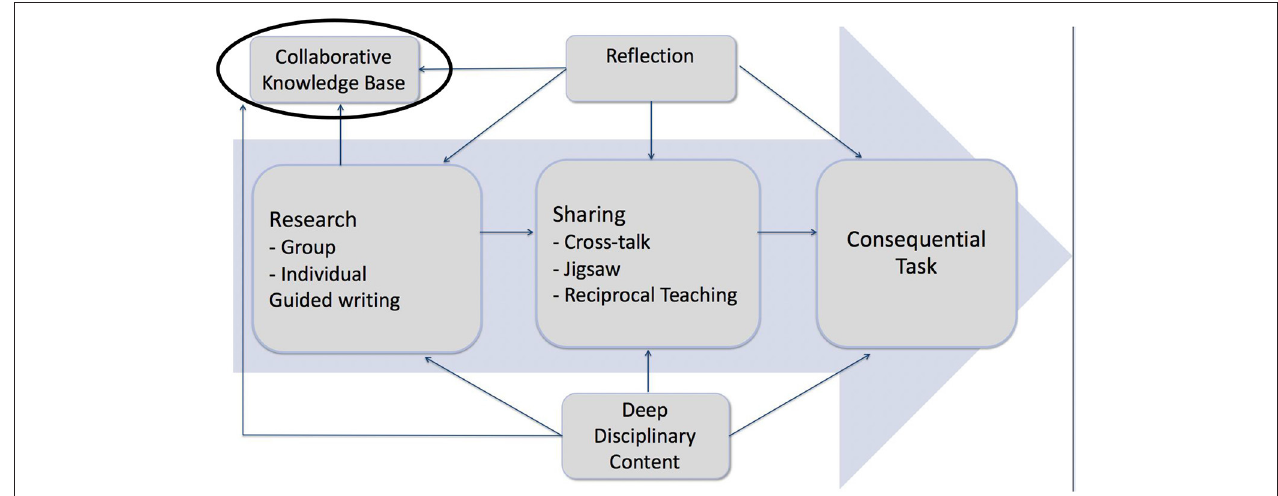
FIGURE 1 | FCL model with the addition of KCI-inspired Collaborative Knowledge